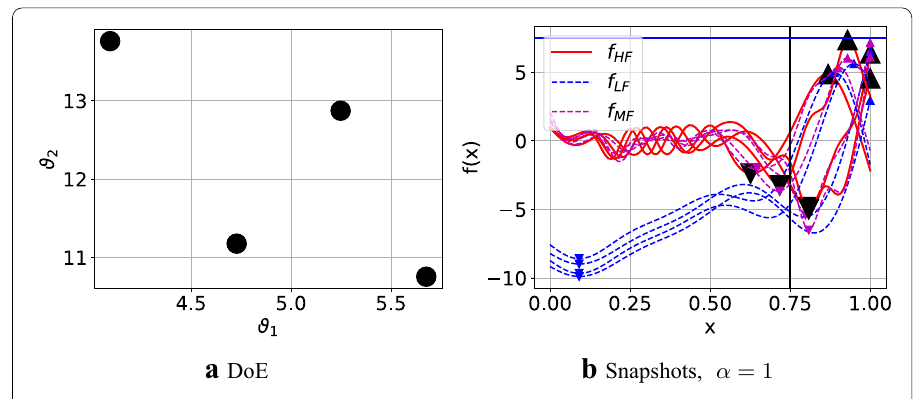
Fig. 3 Snapshots obtained for the 4 points DoE when the HF (continuous red curves), LF (dashed blue curves), and MF (dotted purple curves) models are used with α = 1